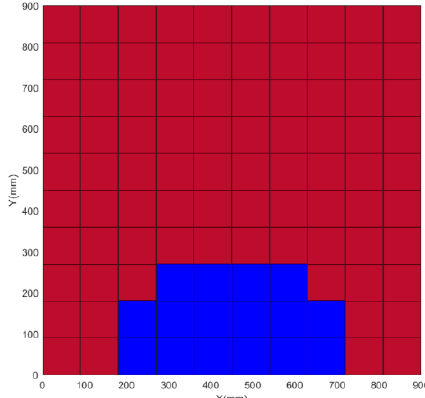
Figure 11. ( a – e ) Echo signals and PAETs of each sub-region. ( f ) The scanning trajectories of each sub-region in ( a – e ).